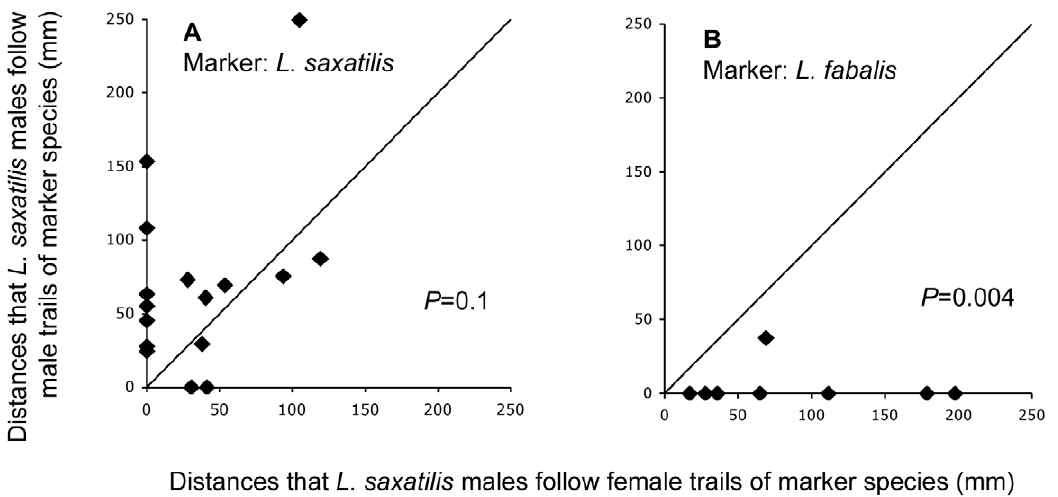
Figure 3. Littorinasaxatilis males tracking males and females of their own or an other species ( L.fabalis ). (A) Distances that males of L. saxatilis followed males and females of their own species. (B) Distances that males of L. saxatilis followed males and females of L. fabalis . Experimental conditions and statistical tests as in Figure 1.